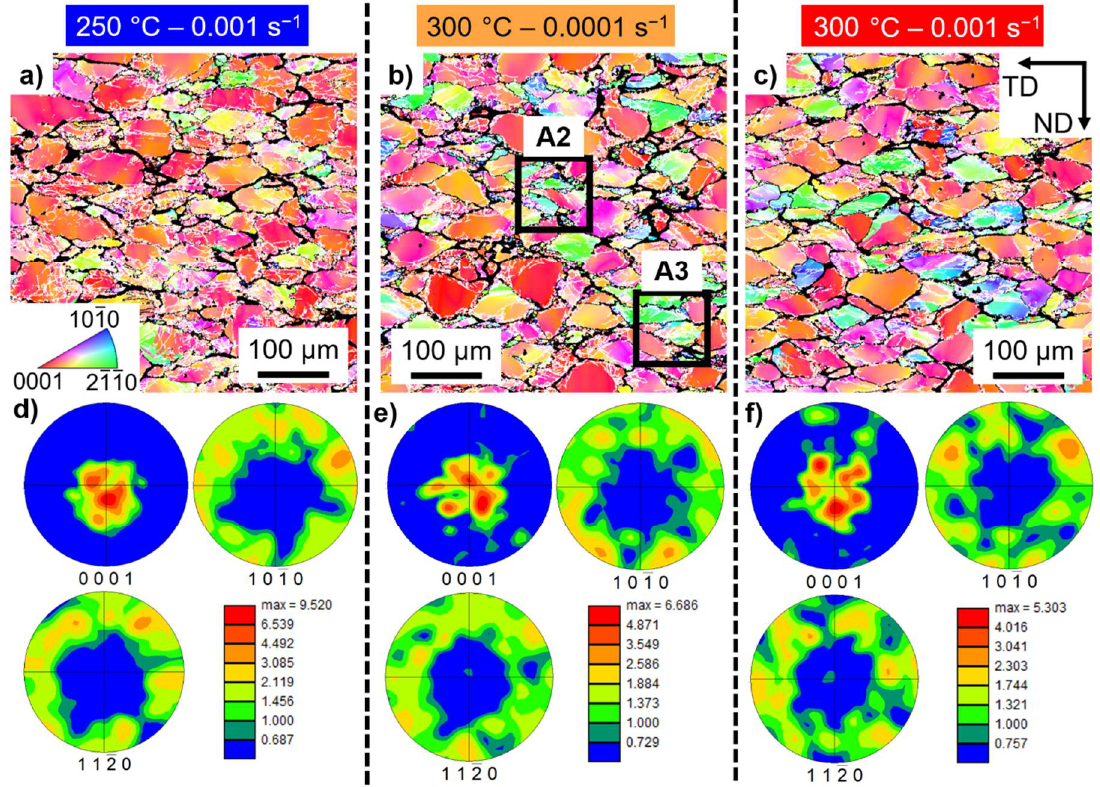
Figure 5. Electron backscattered diffraction results for the ZK40-Gd alloy: ( a – c ) inverse pole figure maps and ( e , f ) pole figures. The tested conditions: ( a , d ) 250 °C and 0.001 s −1 ; ( b , e ) 300 °C and 0.0001 s −1 ; ( c , f ) 300 °C and 0.001 s −1 . Only α-Mg is indexed. Non-indexed regions are highly deformed regions or intermetallic compounds. White and black lines indicate low and high angle grain boundaries, respectively. Areas A2 and A3 are shown in Figure 14. ND and TD indicate the compression and transversal directions, respectively.